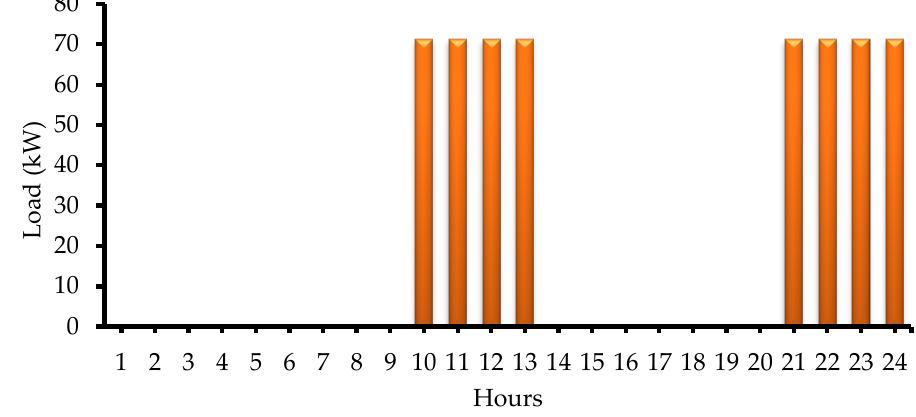
Figure 7. Average hourly operation theatre load consumption.